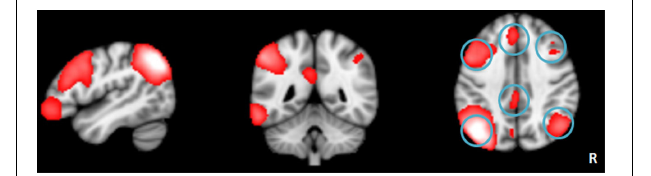
FIGURE 1 | The left frontoparietal network identified by independent component analysis.